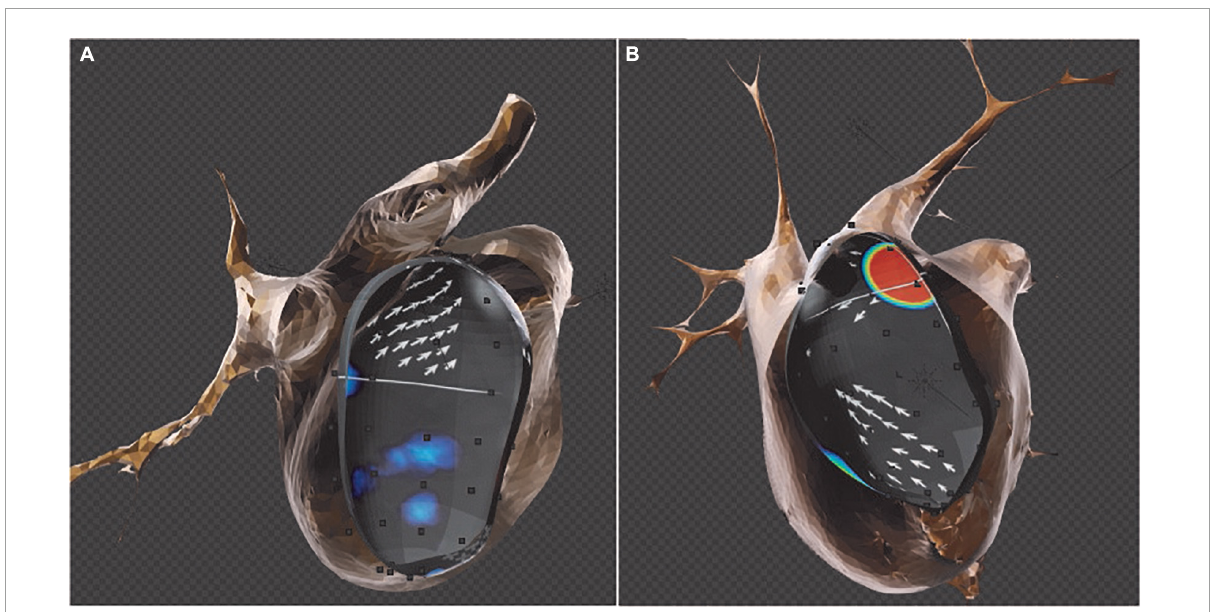
FIGURE3 Merged computed tomography (CT) and electrographic flow (EGF) map reconstructions. Sources detected by the EGF software are projected on the CT surface to demonstrate the exact anatomical location within the cardiac chamber. (A) EGF map reconstruction shows electric flow emerging from the left inferior pulmonary vein (LIPV) (see white arrows). (B) EGF reconstructions identify an extra-PV source emerging from the ridge between left atrial appendage–left superior pulmonary vein (LAA-LSPV) (orange